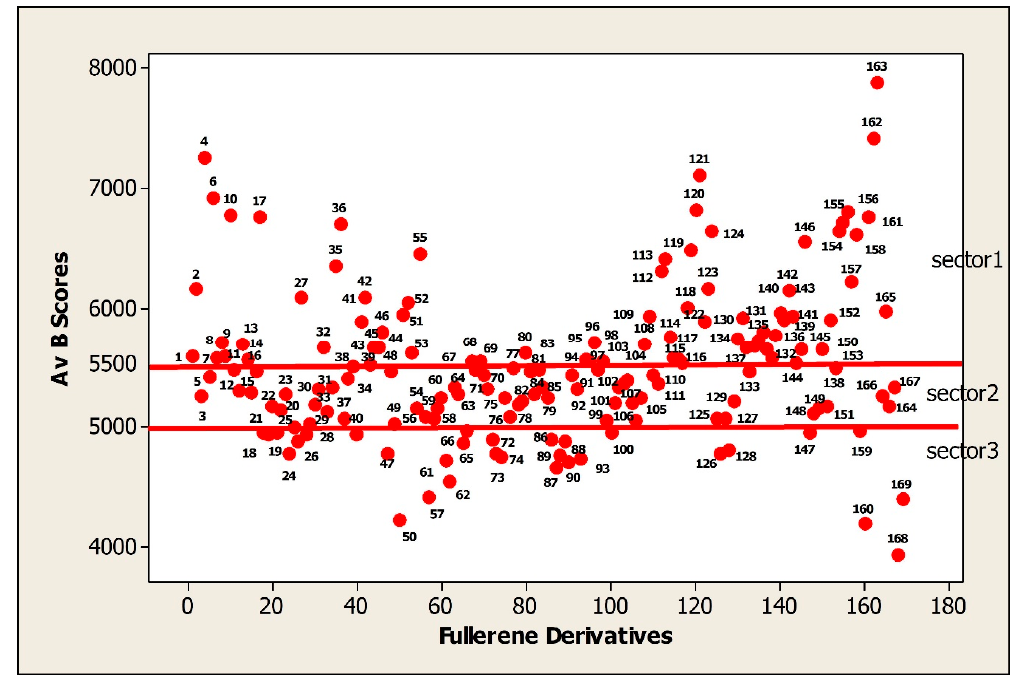
Figure 2. The distribution of fullerene derivatives according to their binding activities.